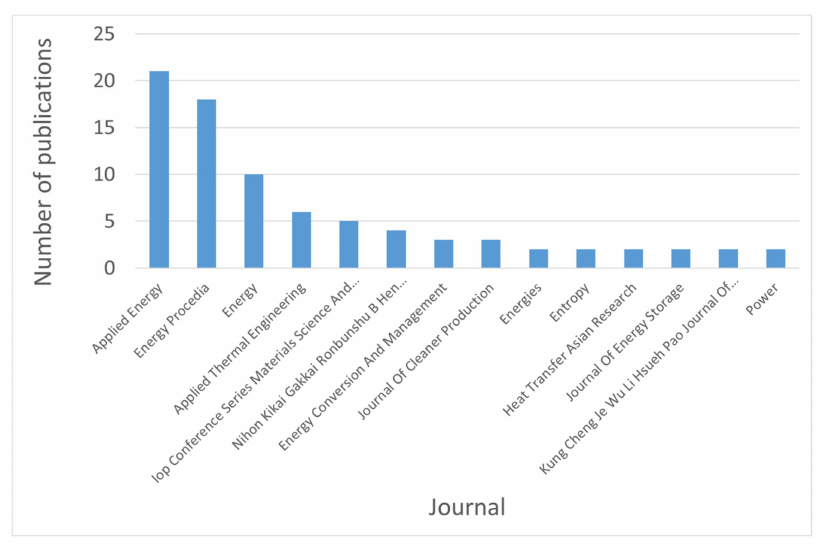
Figure 5. Journals with publications in the topic of